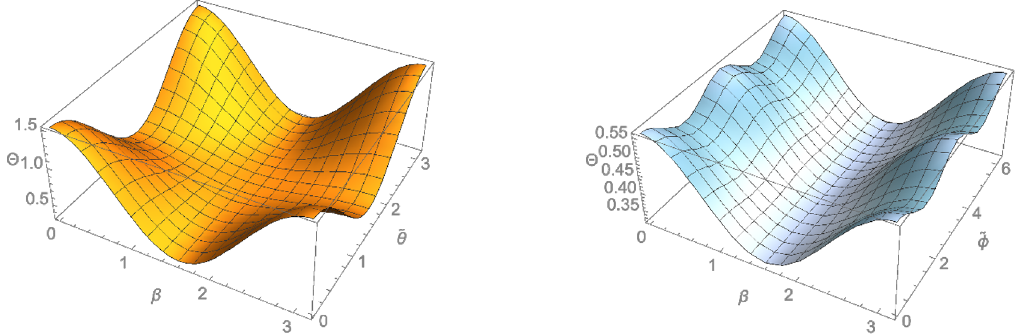
Figure 2. Left: the function (cid:2)( (cid:12); ~ (cid:18) ) for the N = 0 U(1) d (cid:2) SO(3) R solution with cosmological con- stant V = (cid:0) 23 : 4561 g 2 c (cid:0) 1 3 . The behaviours of (cid:2)( (cid:12); ~ (cid:18) ) for the solution with the same symmetry and V = (cid:0) 23 : 4588 g 2 c (cid:0) 1 3 , and of (cid:2)( (cid:12); ~ (cid:18); ~ (cid:30) ) at (cid:12)xed ~ (cid:30) for the N = 0 SO(3) R solution, are qualitatively ; ~ (cid:30) ) for the N = 0 SO(3) R similar. Right: the function (cid:2)( (cid:12); ~ (cid:18) = (cid:25) 2